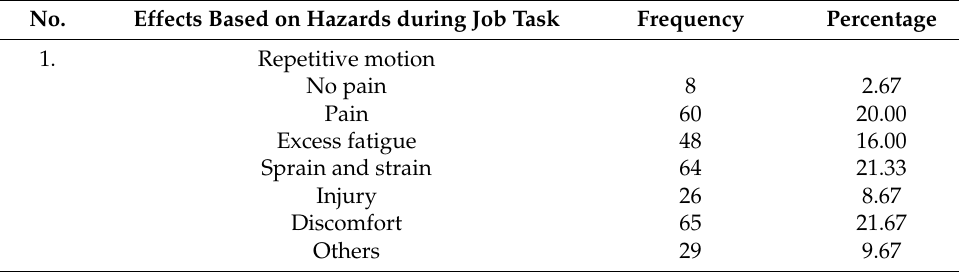
Table 4. Risk assessment based on the HIRARC guidelines